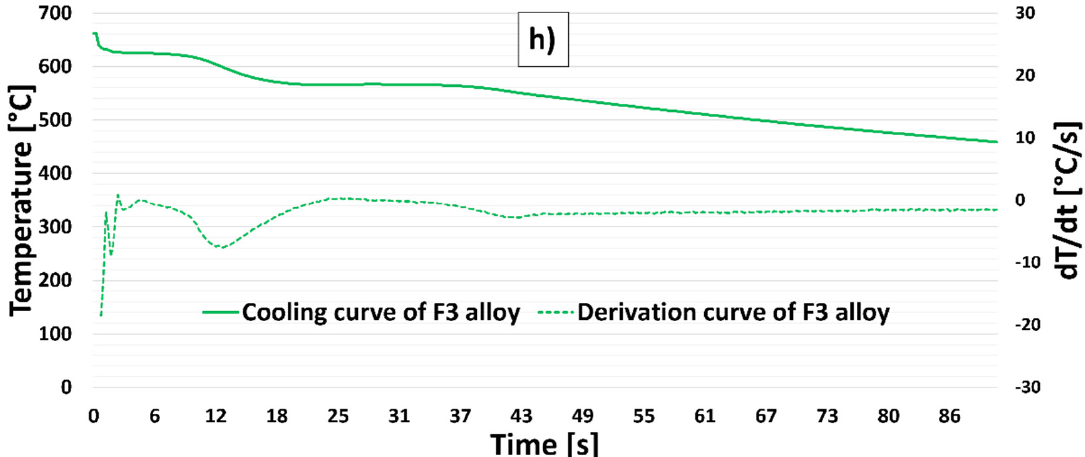
Figure 2. Cooling curves of their first derivative of experimental alloys; ( a ) R alloy, ( b ) P alloy, ( c ) E1 alloy, ( d ) E2 alloy, ( e ) E3 alloy, ( f ) F1 alloy, ( g ) F2 alloy, and ( h ) F3 alloy.